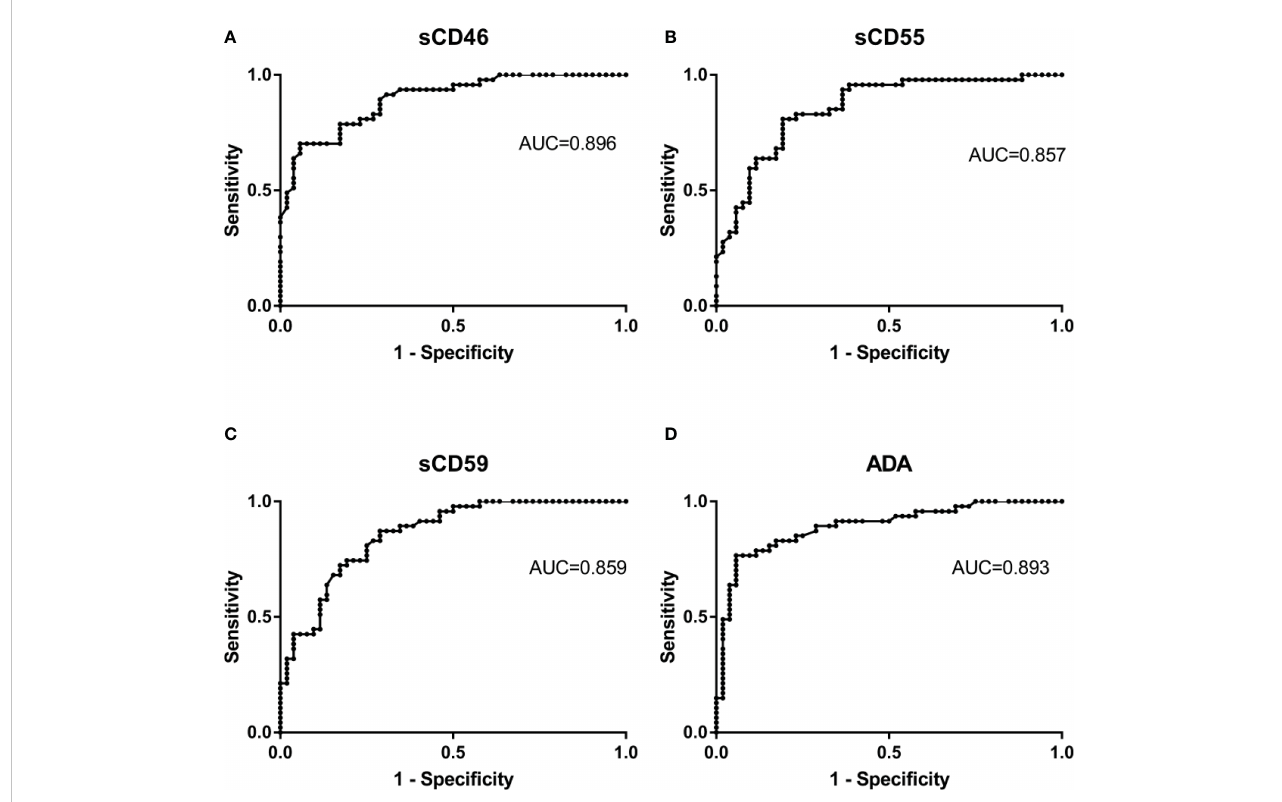
FIGURE 5 Receiver operating characteristic curves of Pleural Fluid sCD46, sCD55, and sCD59 and ADA for TPE. The ROC curves show the diagnostic value of sCD46 (A) , sCD55 (B) , sCD59 (C) and ADA (D) for